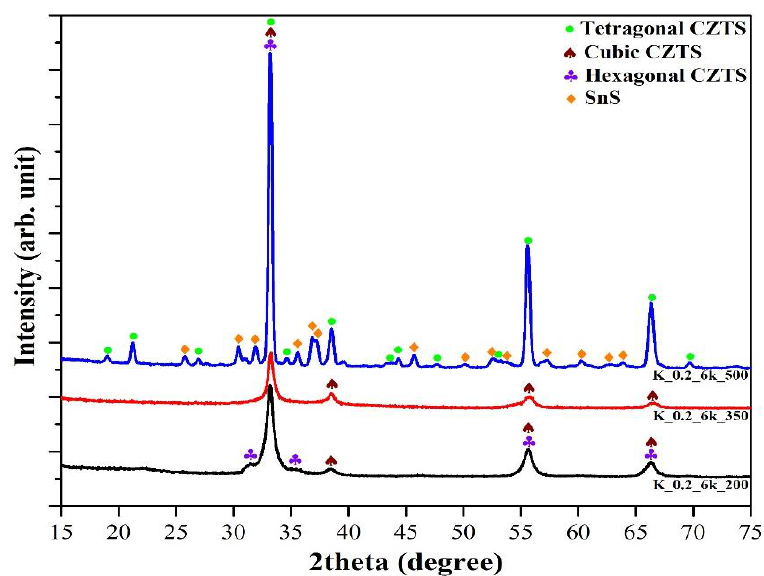
Figure 5. XRD spectra of CZTS thin films treated at 200 °C (black line), 350 °C (red line), and 500 °C (blue line). Identified phases are indicated by corresponding symbols.